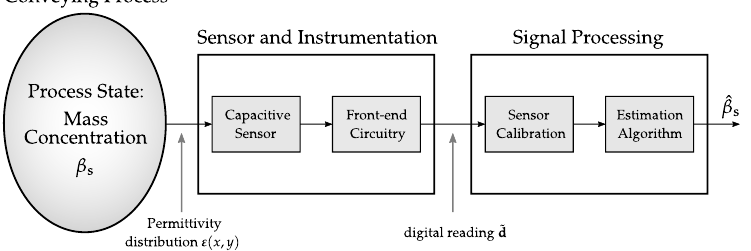
Figure 3. Sketch of a holistic simulation model for capacitive mass concentration measurement in pneumatic conveying